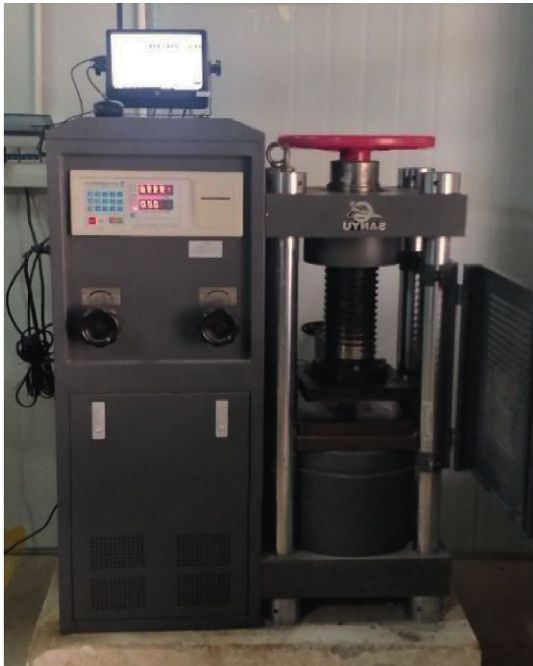
Figure 3: The YAW-2000C constant stress compression testing machine.